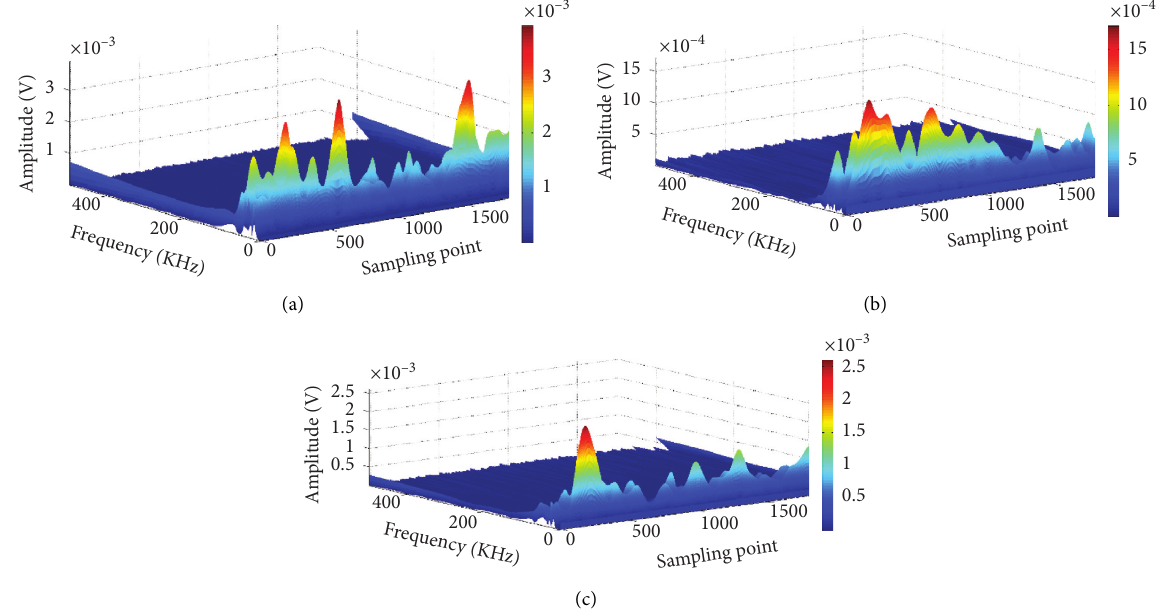
Figure 10: 3D time-frequency diagram of different methods: (a) direct mutual time-frequency analysis method; (b) EMD method; (c) VMD method. Table 2: Multisource leak location results under different